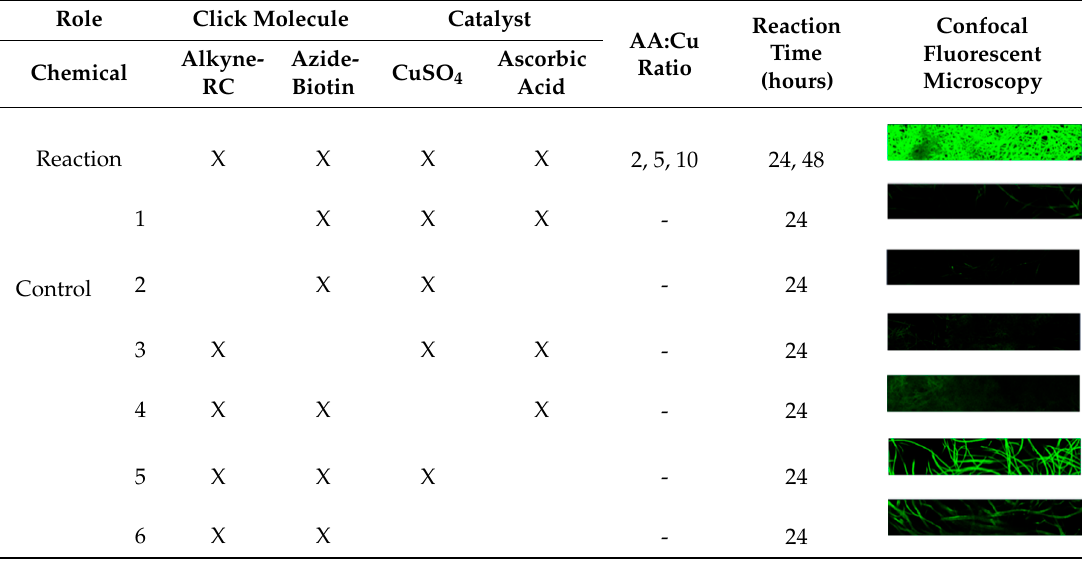
Table 1. Click reaction sample components and confocal images of streptavidin-fluorescein-isothiocyanate (FITC) bound to the click reaction sample membranes.